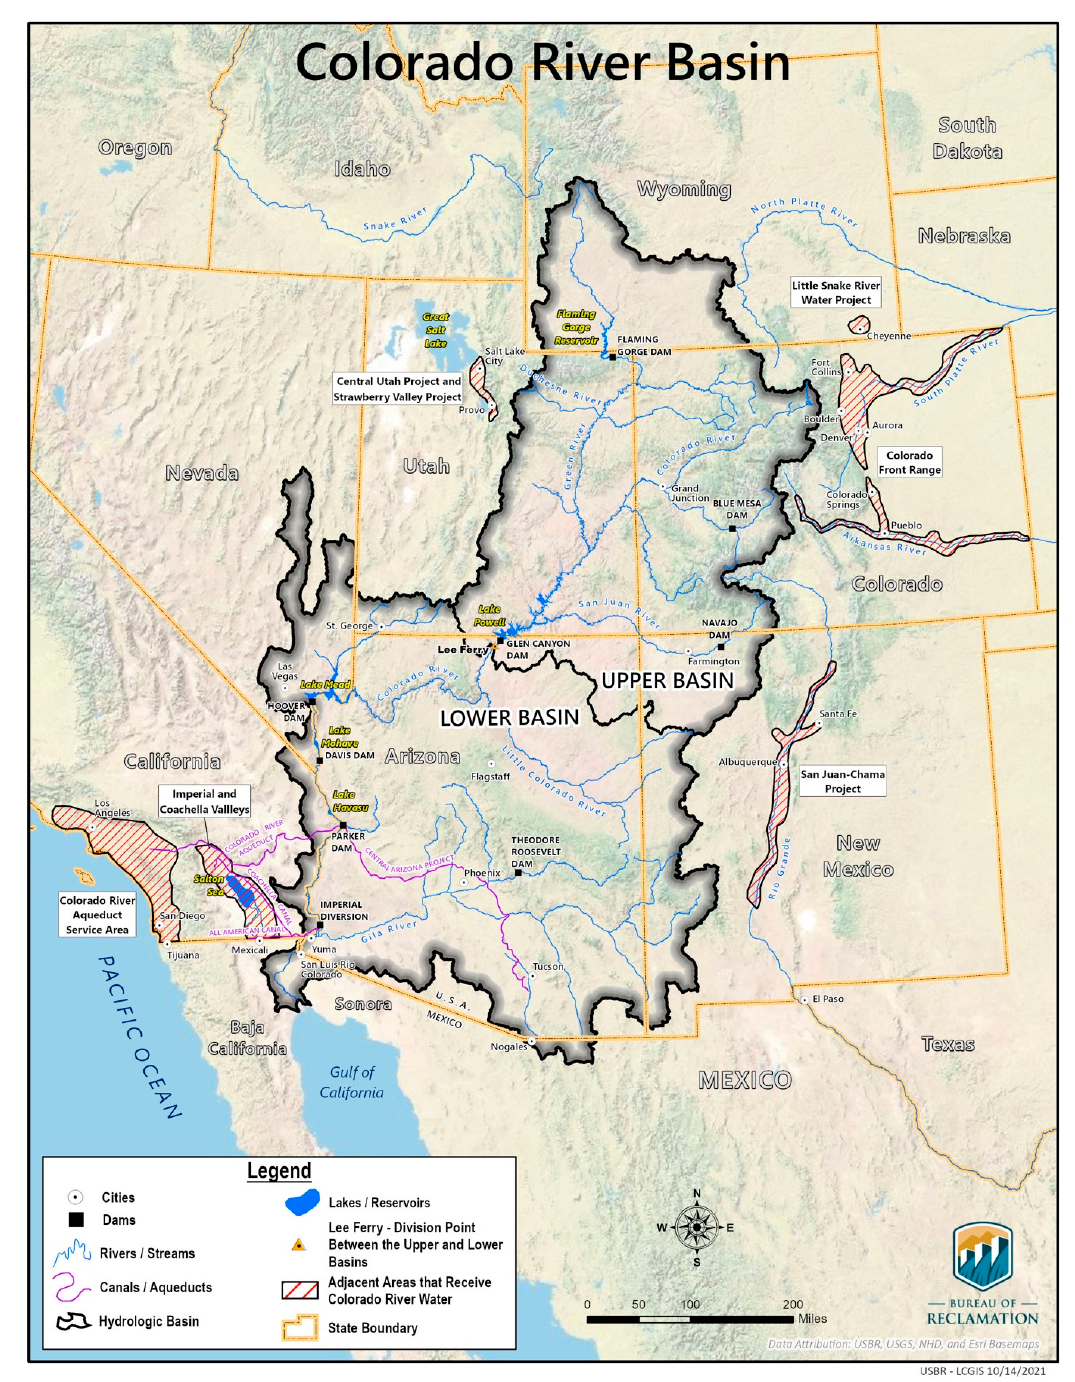
Figure 1. Colorado River Basin. U.S. Bureau of Reclamation.